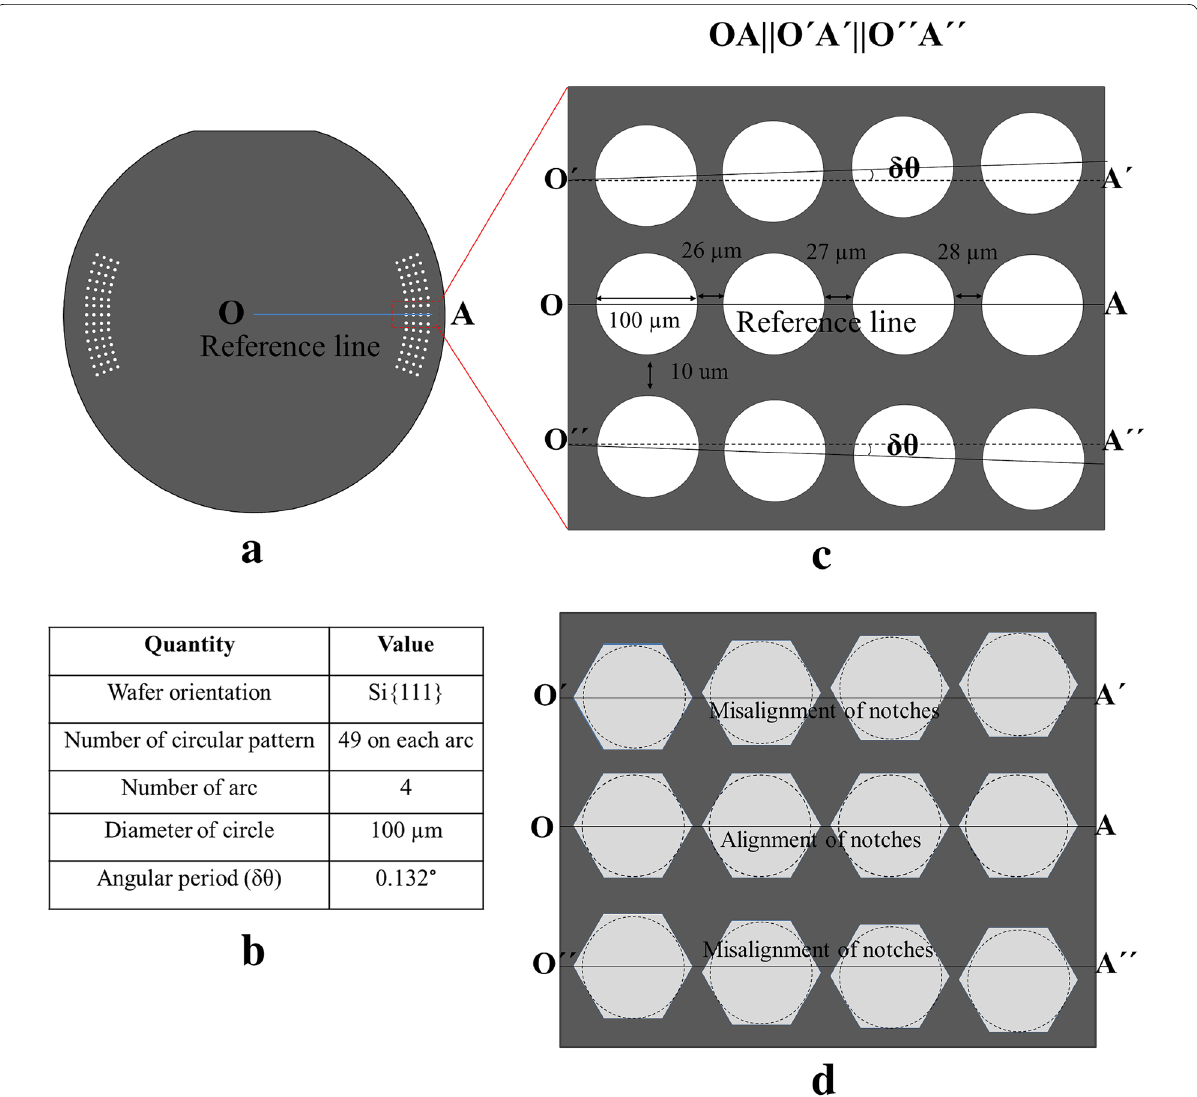
Fig. 4 Schematic view of pre-etched patterns in oxide layer a on Si{111} surface with b quantitative details. Zoomed-in view of pre-etched pattern c before and d after wet anisotropic etching. The line OA indicates where the centres of all circles lie on 〈 110 〉 direction and therefore the notches of hexagon pattern perfectly aligns along 〈 110 〉 direction. The lines O ′ A ′ and O ″ A ″ are parallel to OA indicate the misalignment of the notches when the centres of all circles do not lie on 〈 110 〉